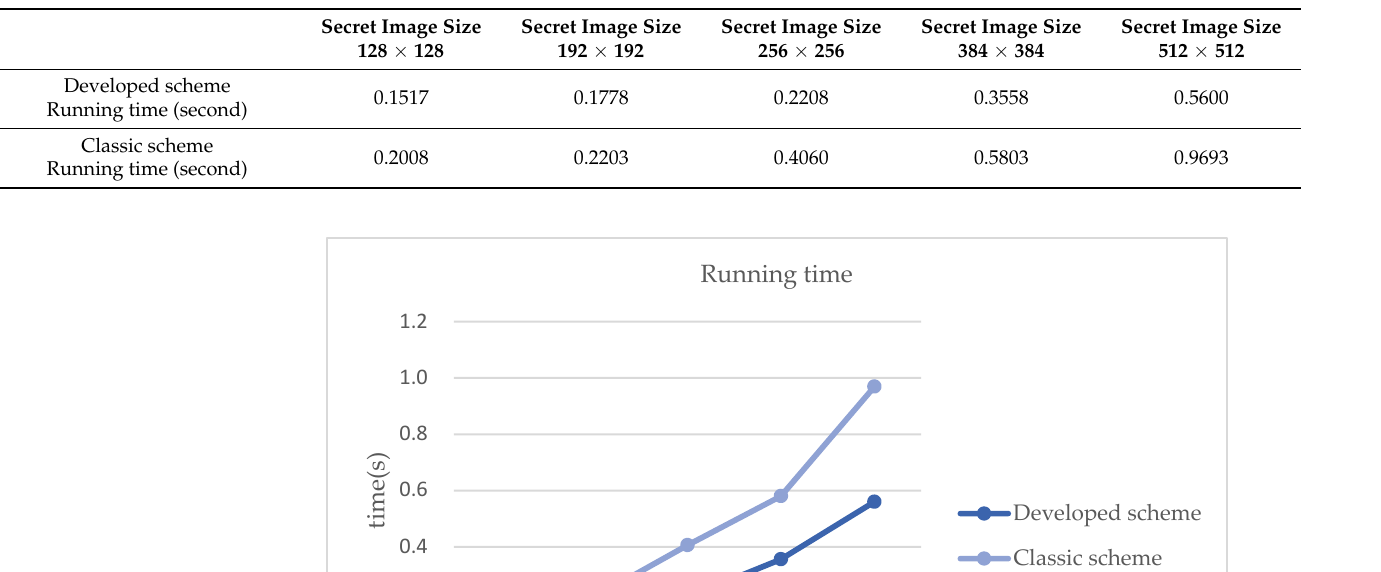
Table 4. Running times with different sizes in GF (251).